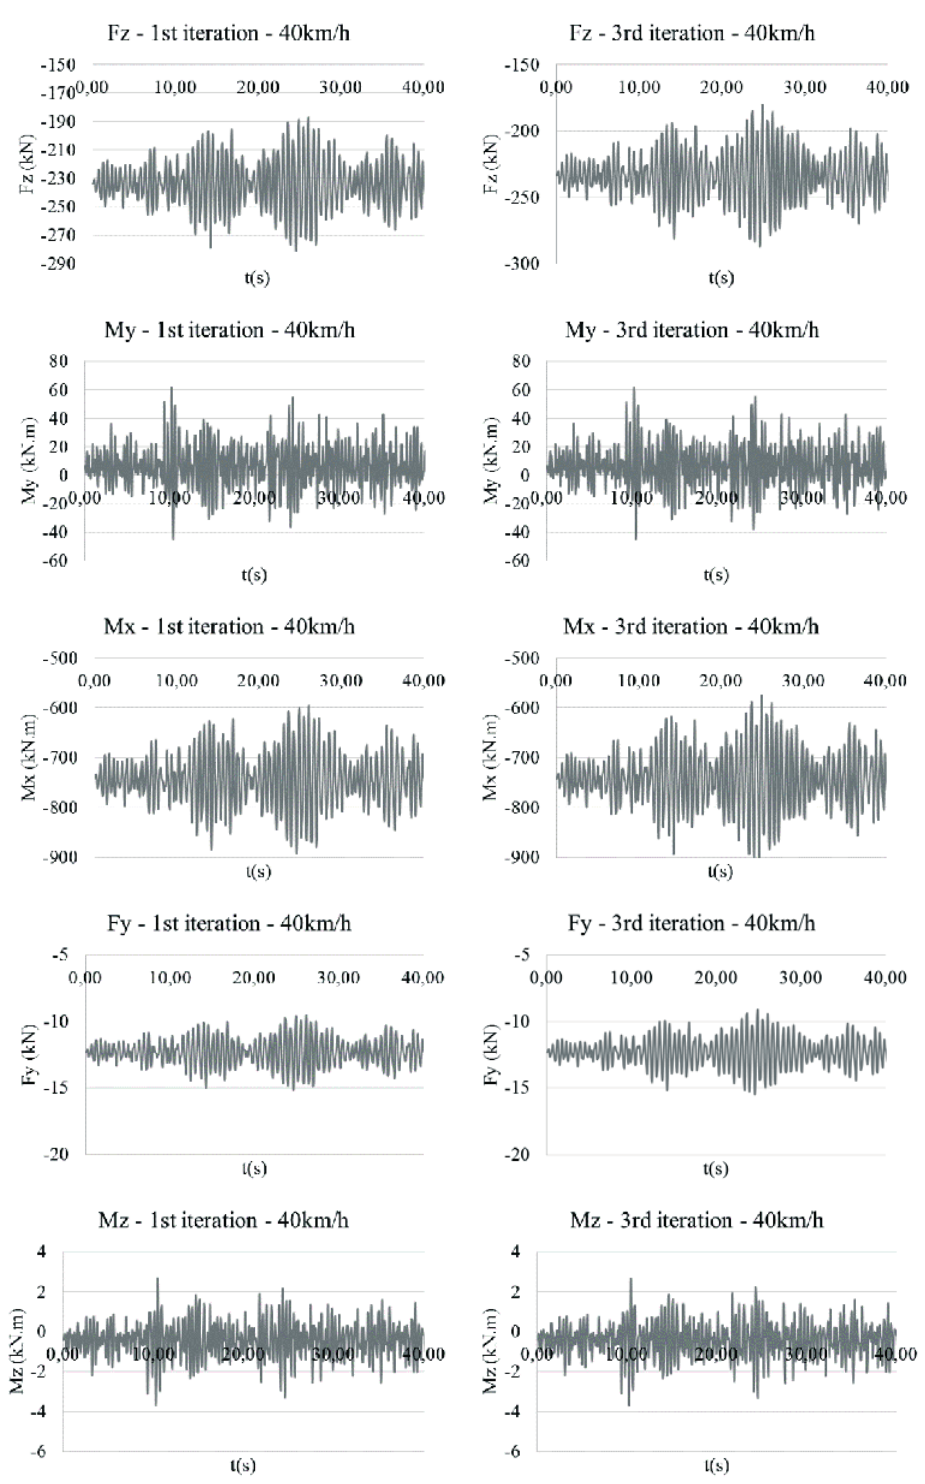
Comparison of the efforts applied to the bridge in the 1st iteration (rigid deck) and 3rd iteration with velocity of 40